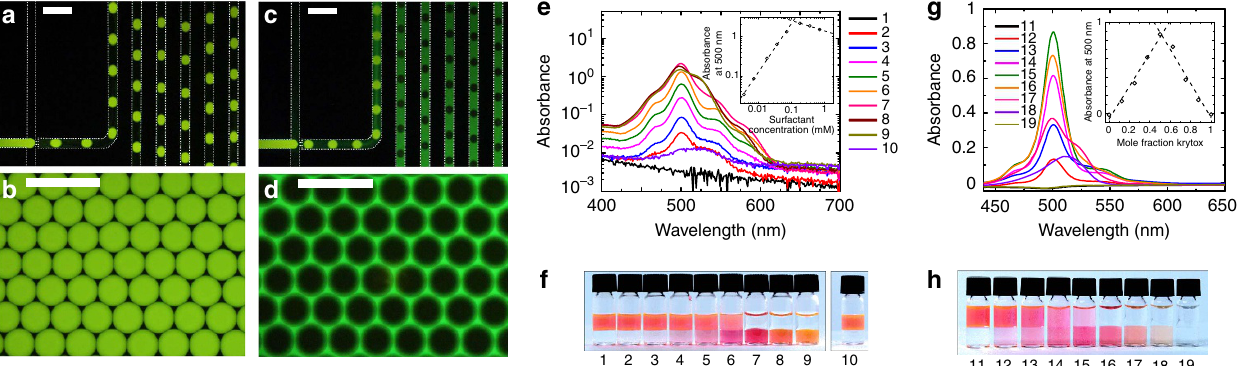
Figure 8 | Surfactant-mediated extraction of solutes. ( a – d ) Fluorescence images of microfluidic droplet production and resulting emulsions in the presence of 0.5% PFPE–PEG–PFPE surfactant and additionally low ( a , b o 1%) or high ( c , d ¼ 30%) mass fractions of carboxylic acid fluorosurfactants (scale bar, 300 m m). The aqueous and fluorous phase flow rate are 1 and 4 m lmin (cid:2) 1 , respectively. ( e – h ) Macroscopic partitioning experiments. ( e ) Absorption spectra of the fluorous phase after equilibration shown for various concentrations of the additive. The inset shows the absorption at 500nm. ( f ) Corresponding images of the partitioning experiments. Aqueous solutions of rhodamine 6G (initial concentration: 100 m M) are exposed to the fluorous phase with additive concentrations from 1 to 9 as: 0, 3.75, 7.51, 18.8, 37.5, 93.8, 188, 375 and 751 m M. Solution 10 contains only the PFPE–PEG–PFPE surfactant at a concentration of 877 m M (0.5wt%). ( g ) Absorption spectra of the fluorous phase for various mole fractions of fluorophore and surfactant. Inset: absorbance at 500nm as a function of the mole fraction of the additive (Job plot). ( h ) Images of the corresponding partitioning experiments. In samples 11–19, the fraction of the additive increases as: 0, 0.125, 0.25, 0.375, 0.5, 0.625, 0.75, 0.875,